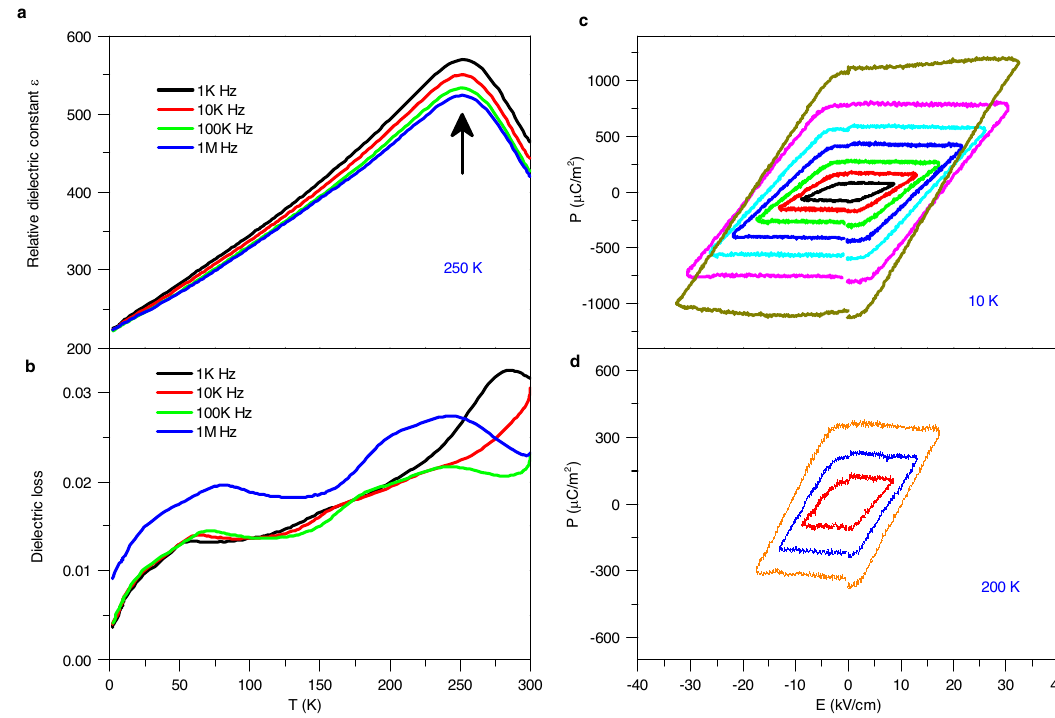
Fig. 4 Dielectricity and ferroelectricity of PHTO. Temperature dependence of a relative dielectric constant ε r , and b dielectric loss at selected frequencies. The P – E hysteresis loops measured at c 10 K and d 200 K under selected electric fi